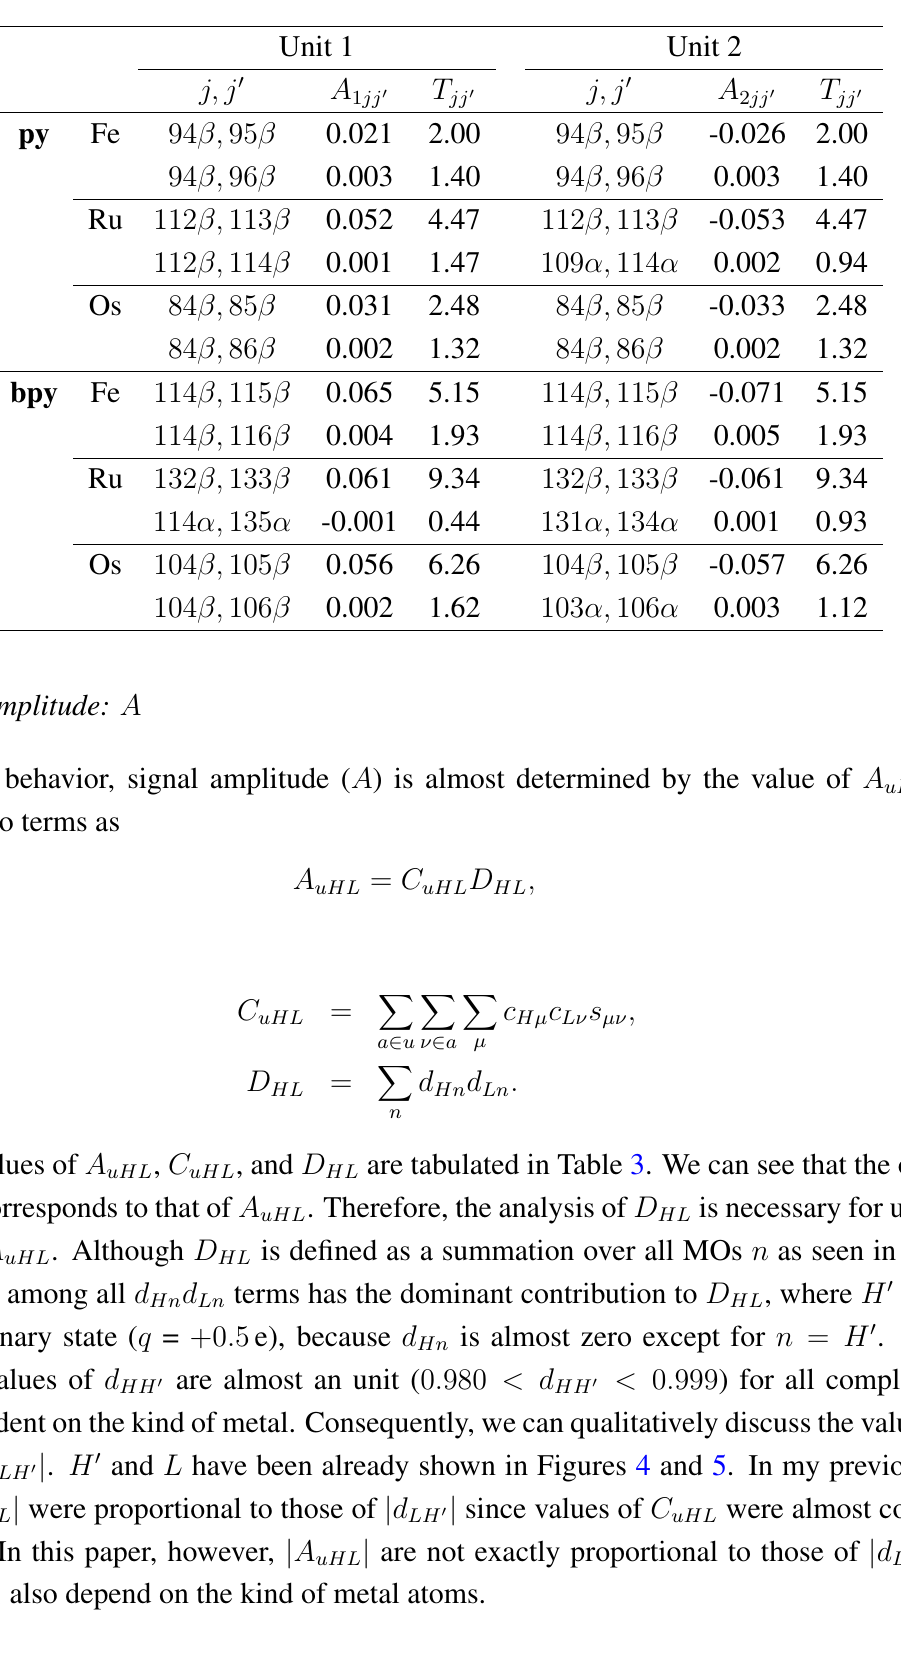
Table 2. Contribution of a set of ( j , j ′ ) orbitals to the time-evolution of Mulliken charge. | (e). For all complexes, the set of Two values of T (fs) are shown in order of | A jj ′ ujj ′ (HOMO( β ), LUMO( β )) gives the largest A ujj ′